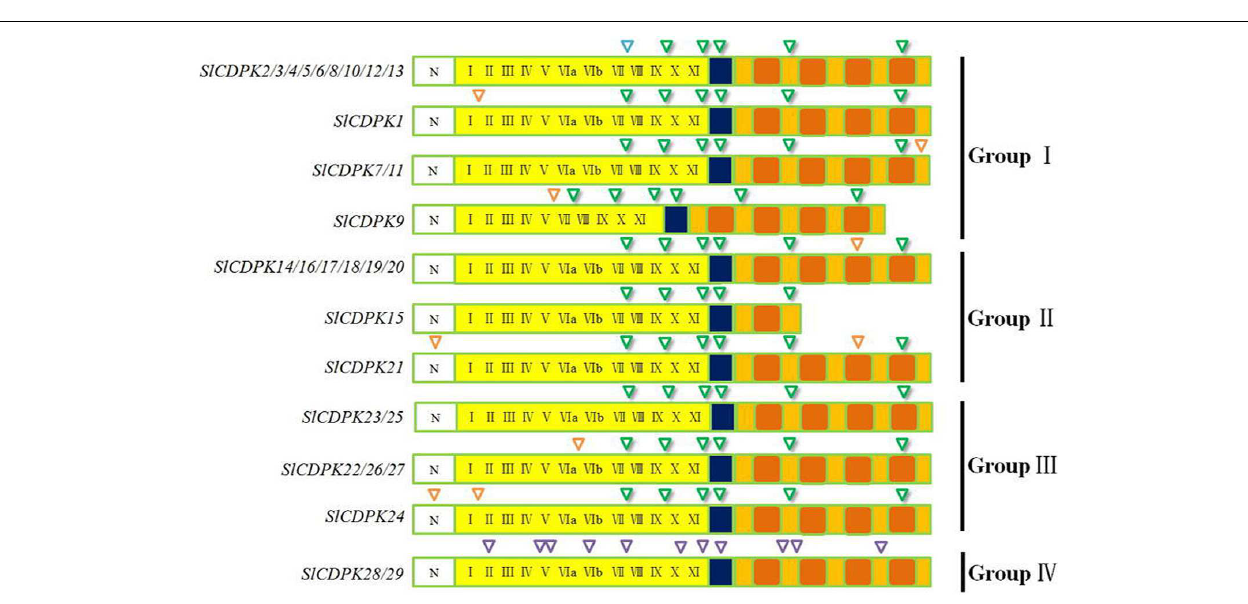
of these Sl CDPKs in ABA signaling remains to be studied in